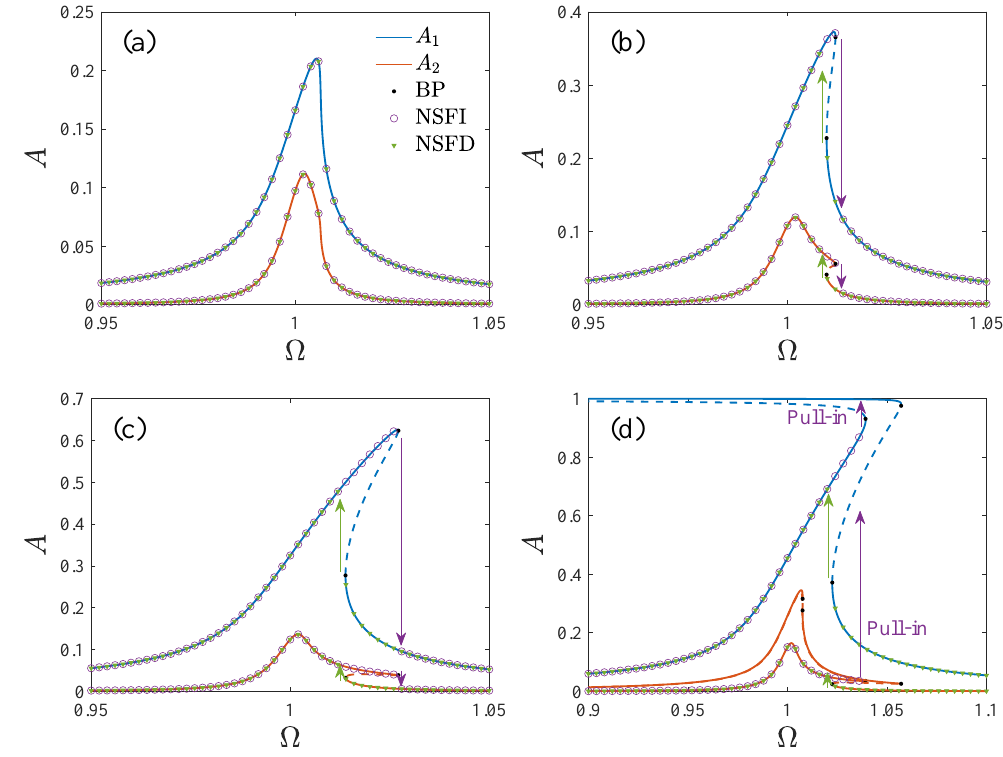
Figure 11. The amplitude–frequency curve versus different parameters, where the solid line is the stable solution, the dashed line is the unstable solution, BP denotes the bifurcation point, NSFI is the numerical solution as the frequency is increased, NSFD is the numerical solution as the frequency is decreased, ( a ) V D = 20 V, V A = 5 V, θ = 2 ◦ , ( b ) V D = 20 V, V A = 10 V, θ = 0, ( c ) V D = 10 V, V A = 30 V, θ = − 1 ◦ , ( d ) V D = 20 V, V A = 20 V,and θ = − 2 ◦